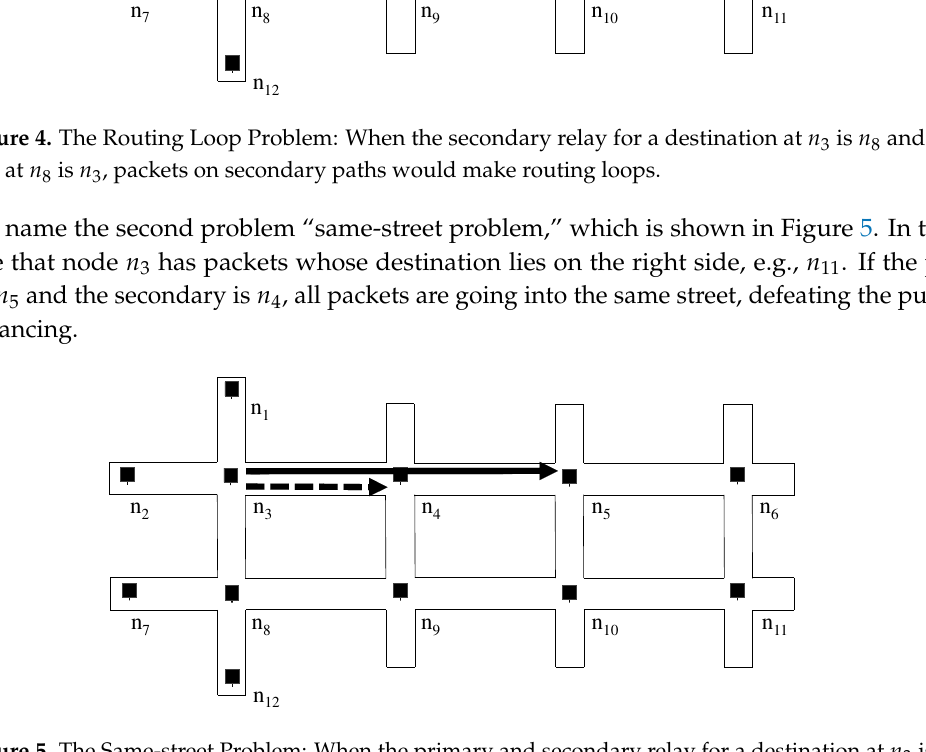
Figure 5. The Same-street Problem: When the primary and secondary relay for a destination at n 3 is n 4 and n 5 , respectively, those paths are along the same street and no load balancing effect is